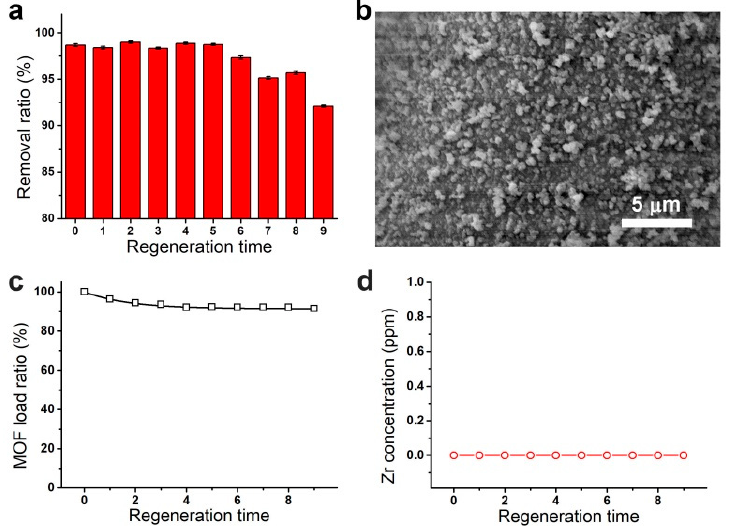
Figure 4. Mercury adsorption after repeated regenerations. ( a ) Removal ratio of Hg 2+ by US-N, ( b ) SEM image of US-N after 9 regenerations, ( c ) the remaining MOF load ratio on US-N after different regeneration cycles, ( d ) the Zr 4+ concentration in filtrate after different regeneration cycles.